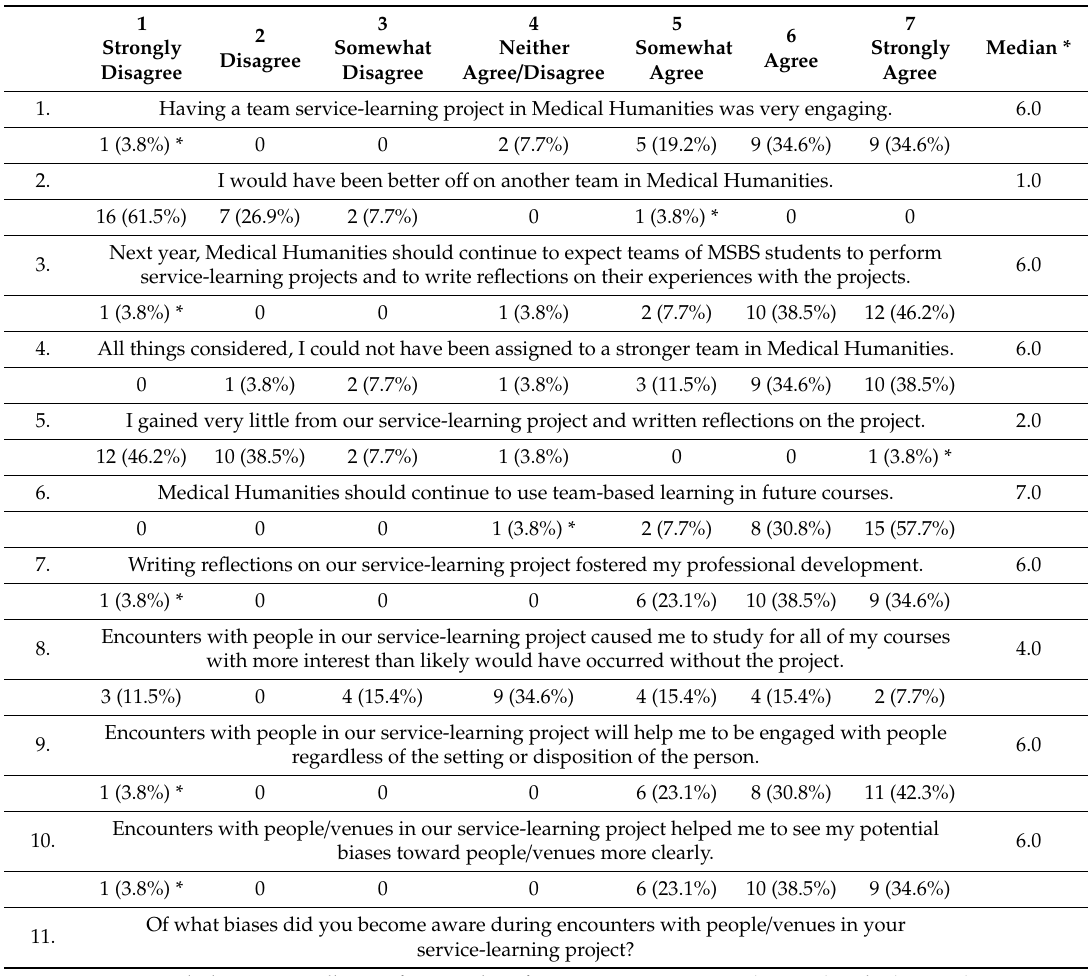
Table 1. Median responses to questions regarding team- and service-learning. Except for item 8, each median is di ff erent from 4.00 ( p < 0.0001). Also shown below each question is the distribution of